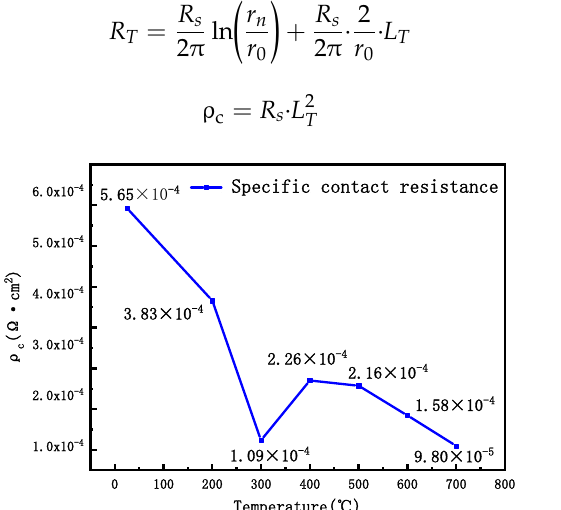
Figure 3. The specific contact resistance values of Pt/Au/H-SCD with different annealing temperature.